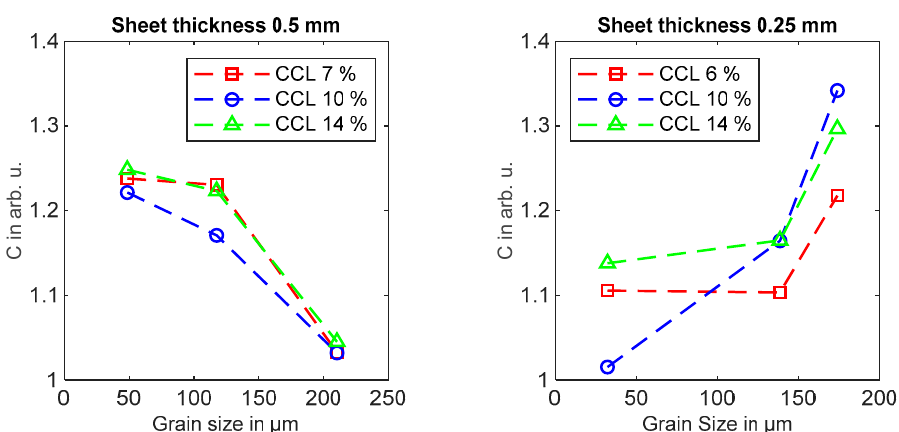
Figure 6. Iron loss factor C in dependence of the average grain size for sheet thicknesses of 0.25 mm or 0.5 mm and for cutting clearances of 6%, 7%, 10% and 14%.